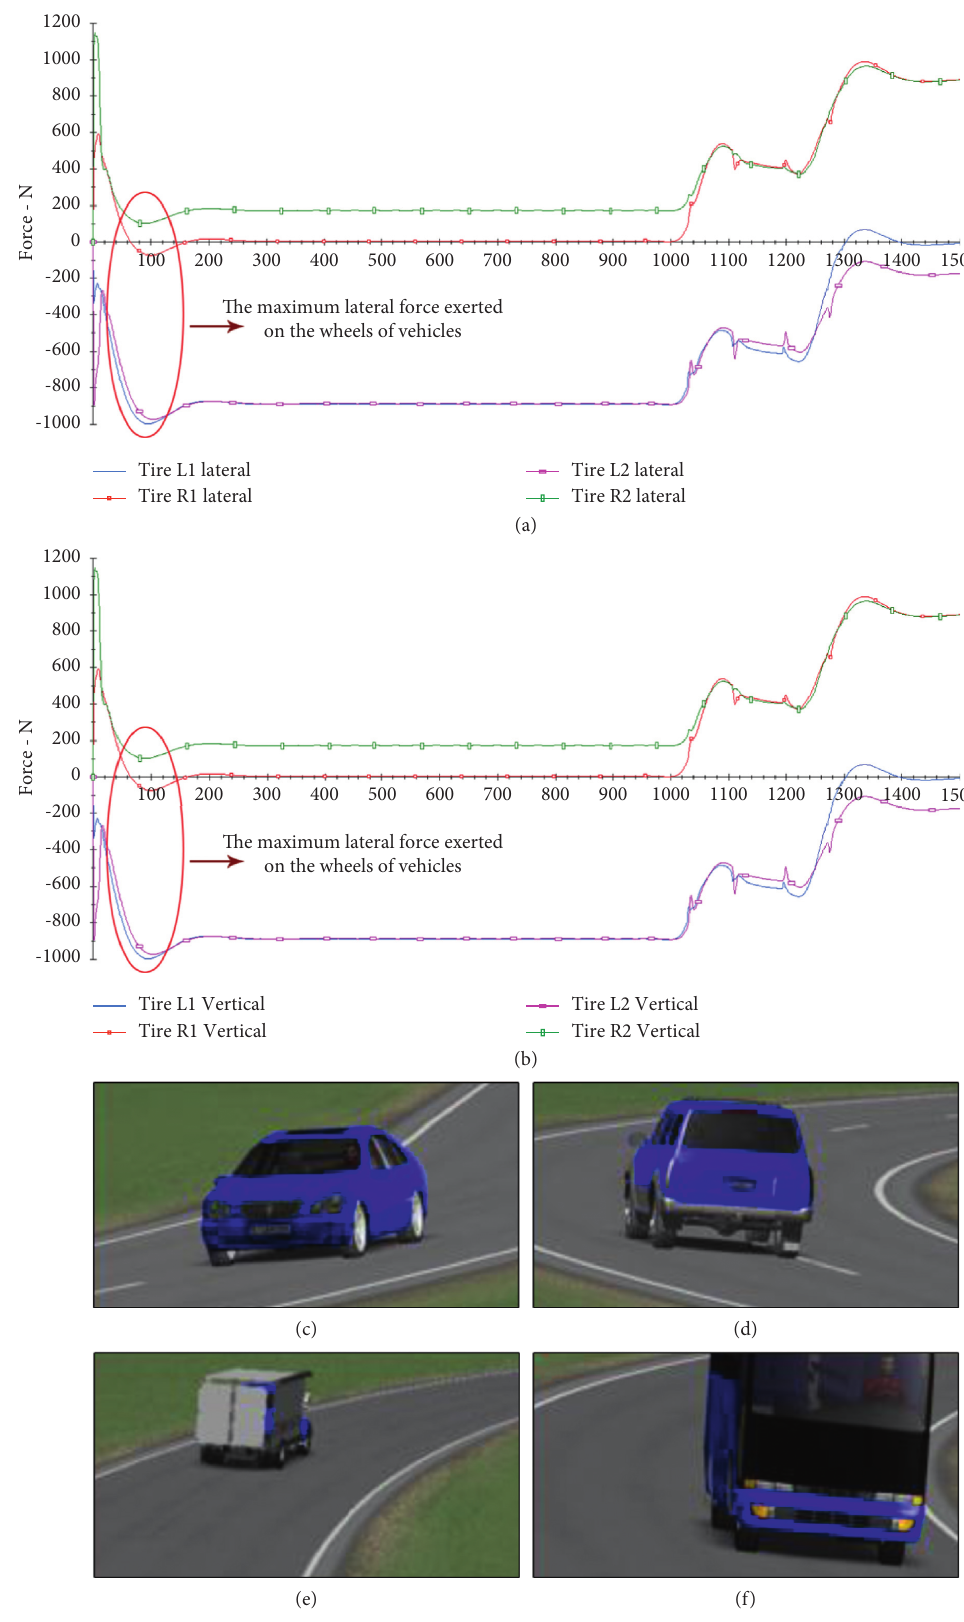
Figure 3: Simulation software output for the scenario with a speed of 120km/h, a direct distance of 202m and a slope of 5%: (a) Lateral force; (b) Vertical force; (c) Sedan vehicle simulation; (d) SUV vehicle simulation; (e) Truck vehicle simulation; (f) Bus vehicle